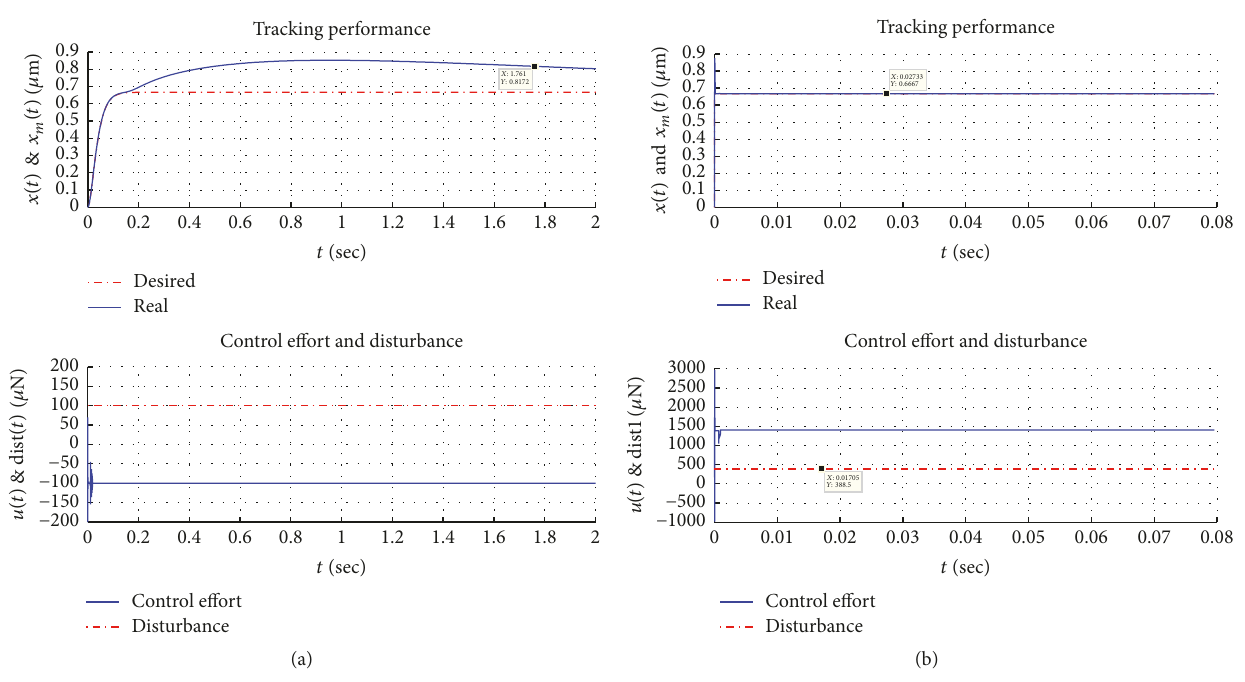
Figure 7: Tracking performance comparison between adaptive sliding mode controller and the conventional one: (a) tracking performance in conventional adaptive controller. It is vulnerable to parameter uncertainty and constant disturbance; (b) tracking performance in adaptive sliding mode controller. It is also prone to parameter uncertainty and constant